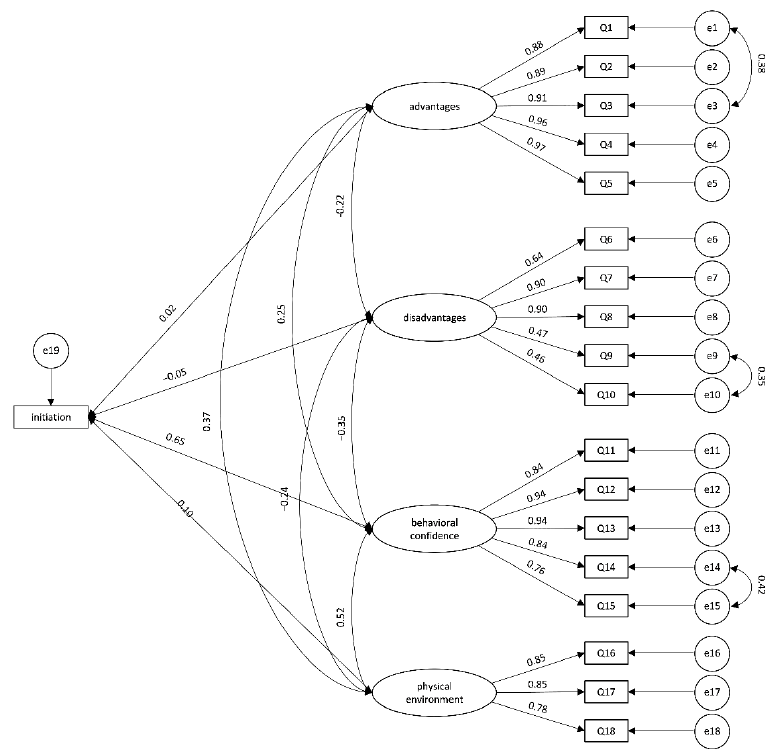
Figure 2. Structural equation model for initiation model.